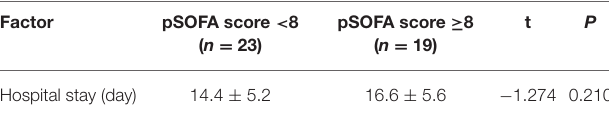
TABLE 2 | Comparison of pSOFA score, lactate level, duration of fever, hospital stay and WBC count between two groups.